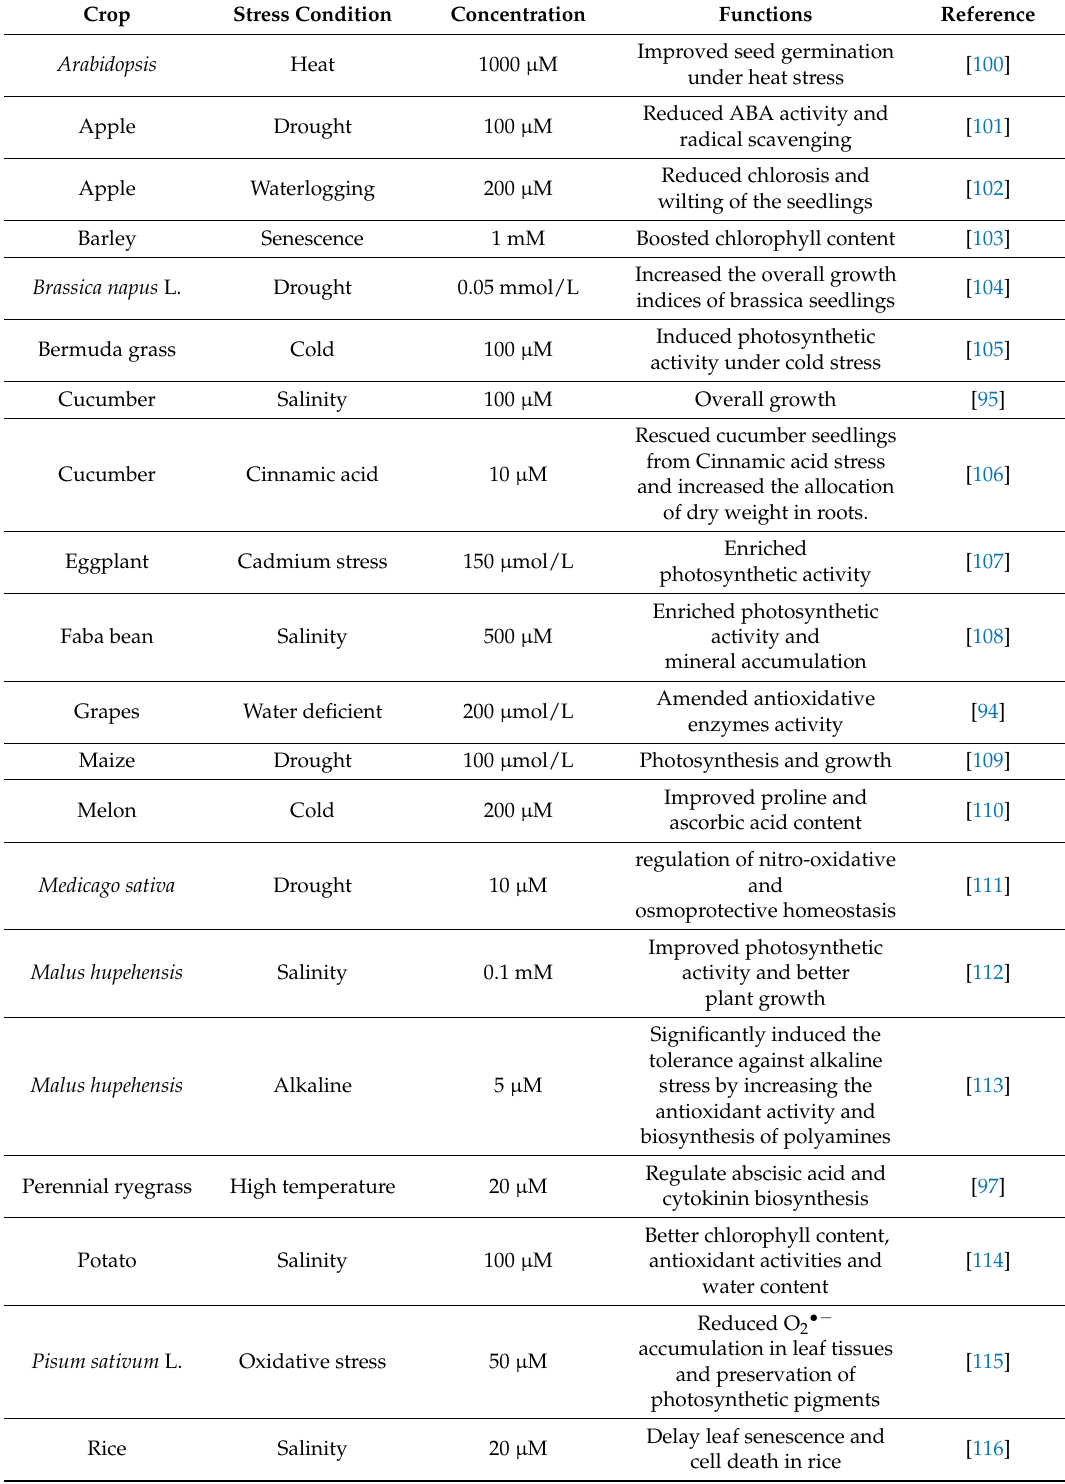
Table 3. Protective role of melatonin in various crops against different abiotic